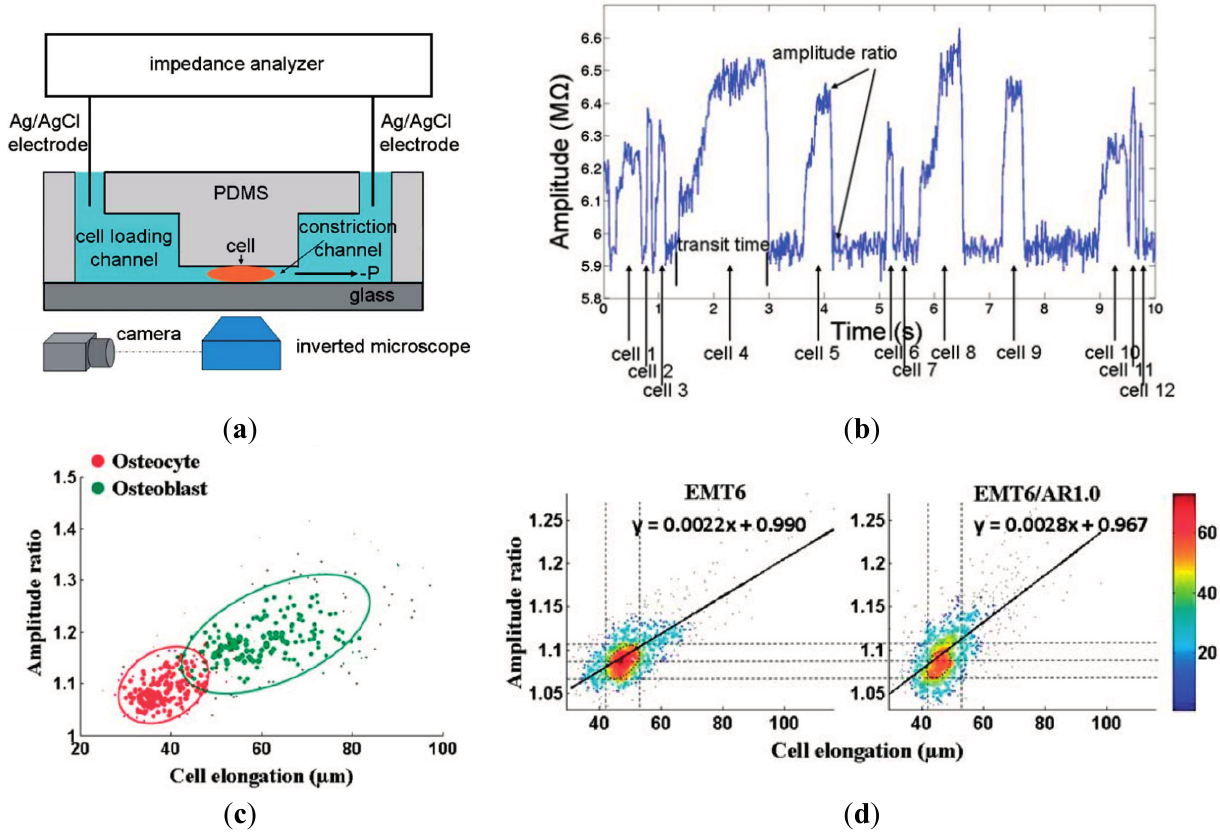
Figure 4. ( a ) The constriction channel based microfluidic impedance flow cytometry where single cells were aspirated through a constriction continuously while cell elongations and single frequency impedance profiles are measured simultaneously; ( b ) Raw impedance data of single cells, recording higher impedance amplitudes during cellular squeezing through the constriction channel; ( c ) The scatter plot of impedance amplitude ratio vs. cell elongation length for osteocytes and osteoblasts. Compared with osteocytes, osteoblasts have a larger cell elongation length and a higher impedance amplitude ratio; ( d ) The scatter plot of impedance amplitude ratio vs. cell elongation length for tumor cell EMT6 and their more malignant counterparts EMT6/AR 1.0, revealing a linear trend between cell elongation length and impedance amplitude ratio with different slopes and different y -axis intersections Reproduced by permission of the Royal Scoeity of Chemistry